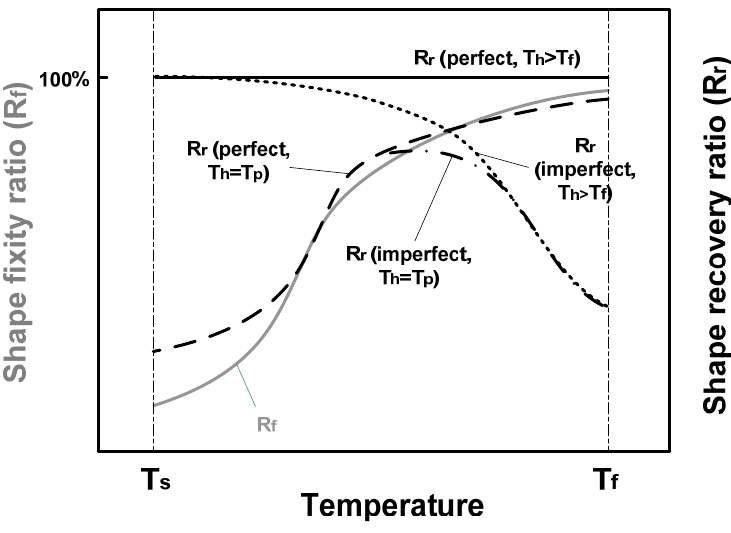
) against programming r